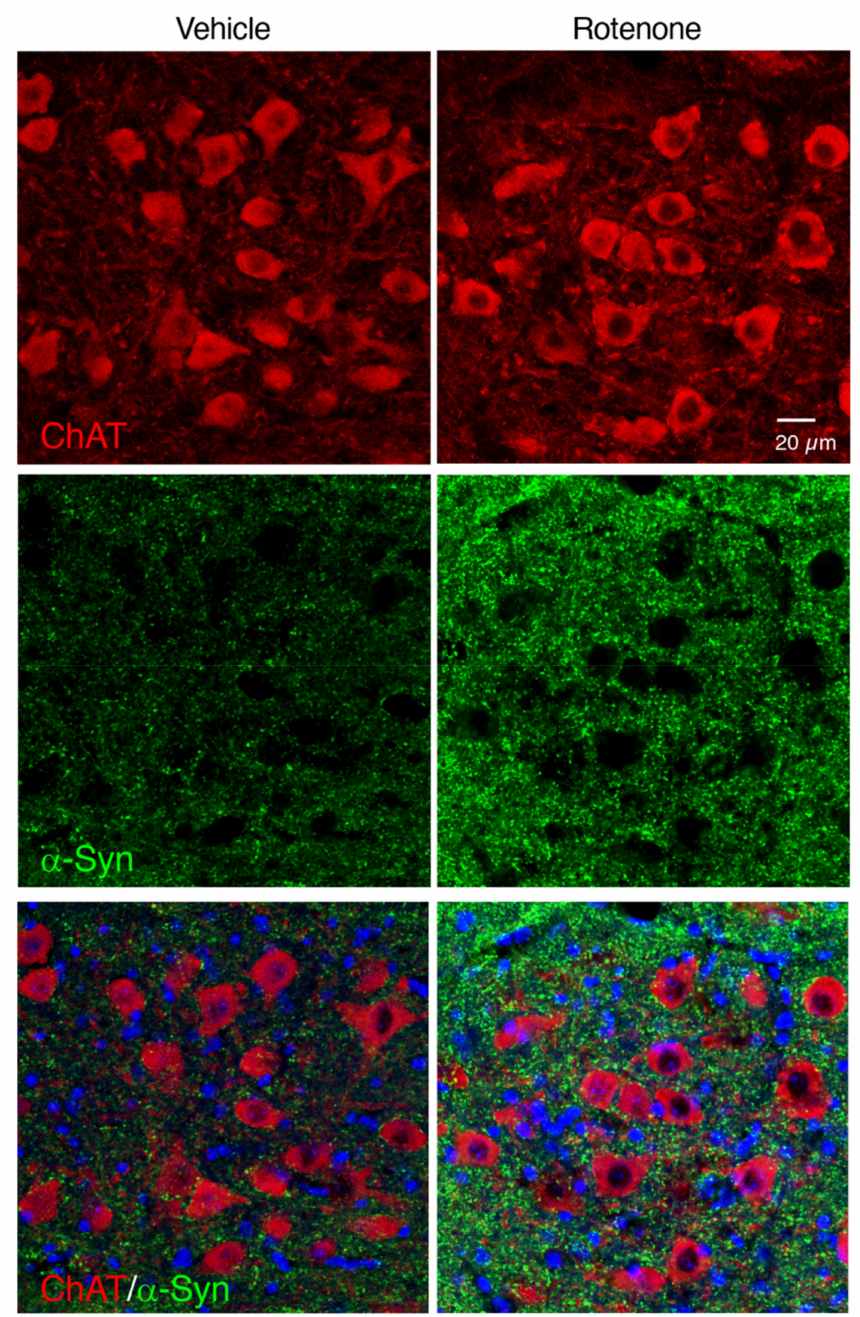
Figure 8. Changes in α -Syn-positive signals in the hypoglossal nucleus of rotenone-treated mice. Representative photomicrographs of ChAT and α -Syn double immunostaining. Red: ChAT-positive neurons. Green: α -Syn. Blue: nuclear staining with Hoechst 33342. Scale bar = 20 µ